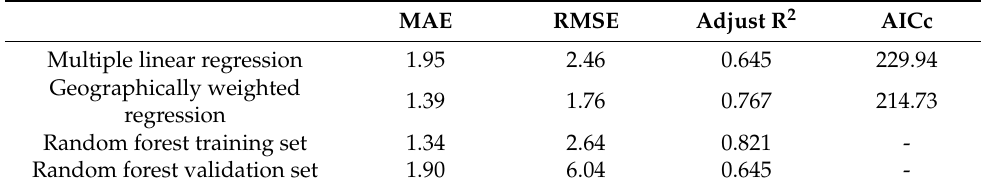
Table 3. Regression model